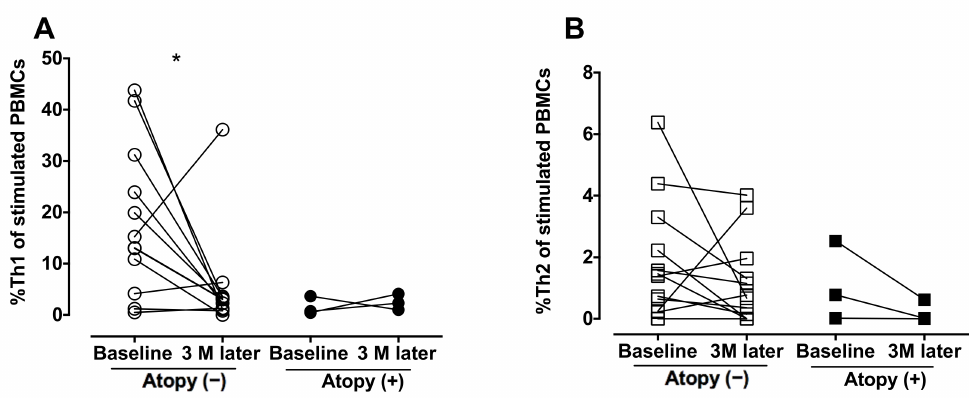
Figure 5. Decrease in peripheral blood Th1 cells after anti-TB treatment. Peripheral blood mononuclear cells were obtained from the TB-infected patients before and after the 3-month anti-TB treatment and stimulated with phorbol myristate acetate and ionomycin. CD4 + /IFN- γ + Th1 cells and CD4 + /IL-4 + Th2 cells were identified by flow cytometry. ( A , B ) The difference between cell profiles before and after medication was determined by paired a t -test. * p < 0.05. %Th1, percentage of type 1 CD4 + T helper cells; %Th2, percentage of type 2 CD4 + T helper cells; TB, tuberculosis; IL-4, interleukin-4; IFN- γ , interferon- γ ; PBMCs, peripheral blood mononuclear